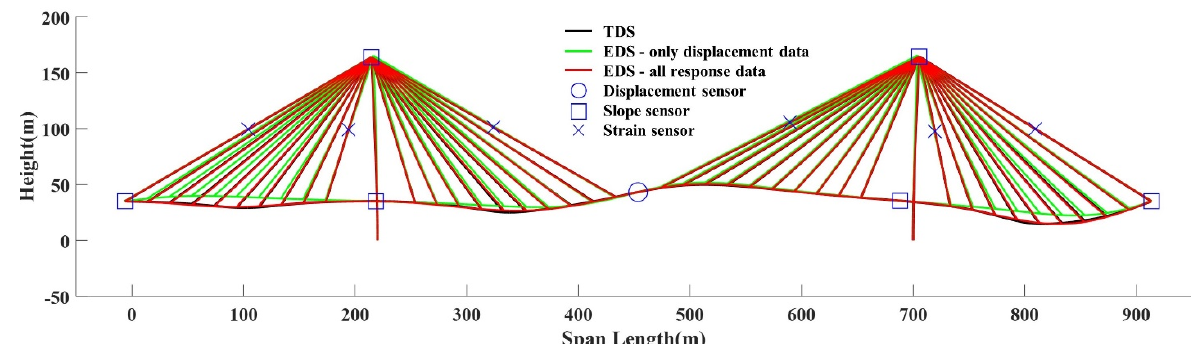
Figure 8. Example of EDS for TM4.